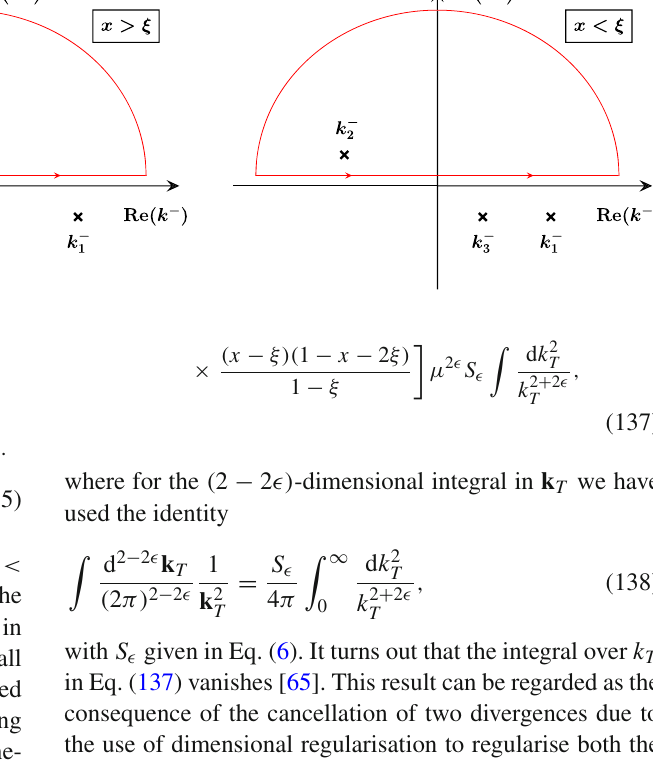
Fig. 11 Position of the poles in the complex plane defined by k − in the integrals in Eq.